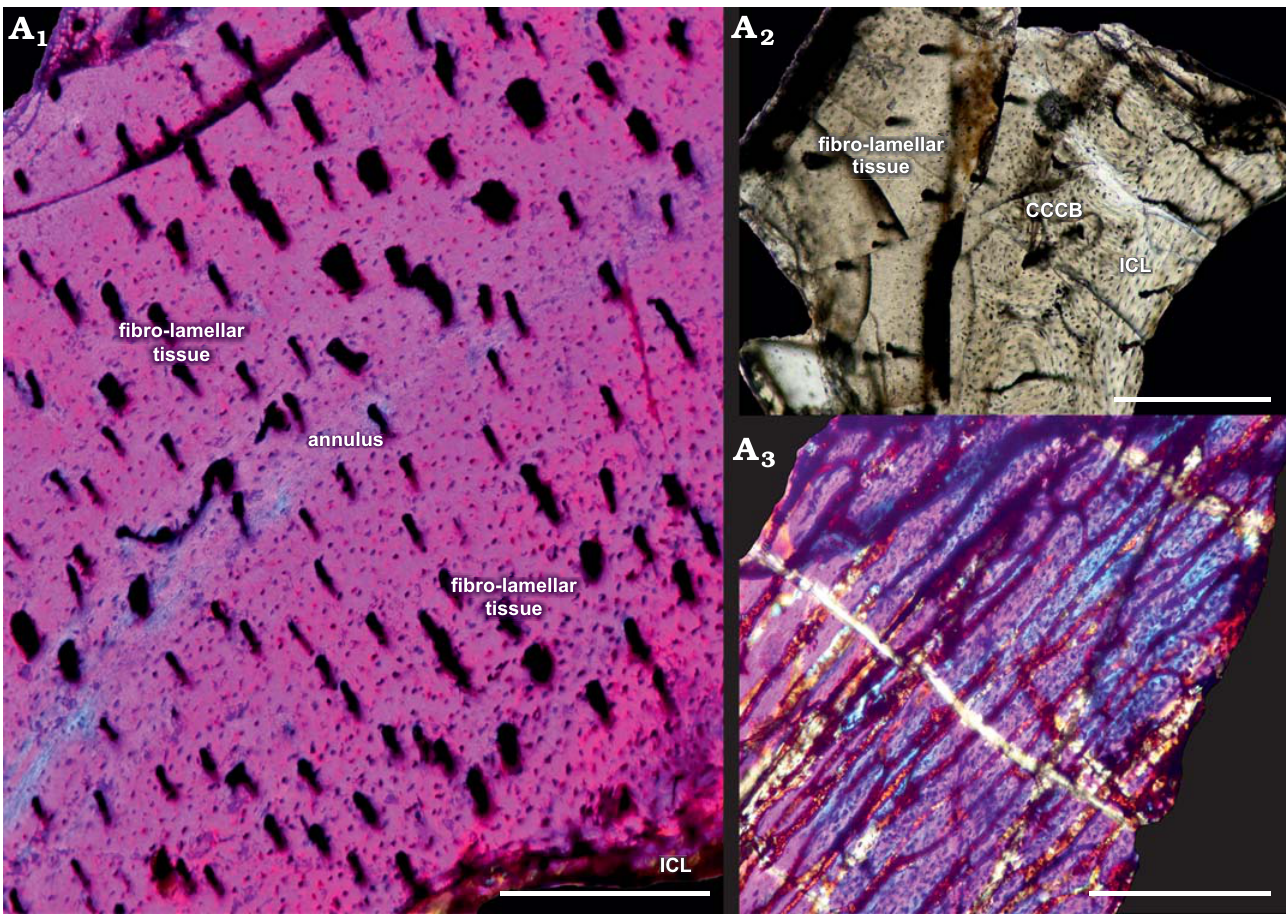
Fig. 2. Femur of archosauromorph Lagerpeton chanarensis Romer, 1971 (PULR-V 124, in lambda light) from La Rioja province, NW Argentina; Chañares Formation, Carnian (Late Triassic). Section showing the inner circumferential layer and the cortex (A 1 ), detail of the compact coarse cancellous bone (A 2 ), oblique section of the same femur (A 3 ). Abbreviations: CCCB, Compact Coarse Cancellous Bone; ICL, Inner Circumferential Layer. Scale bars 300 μ